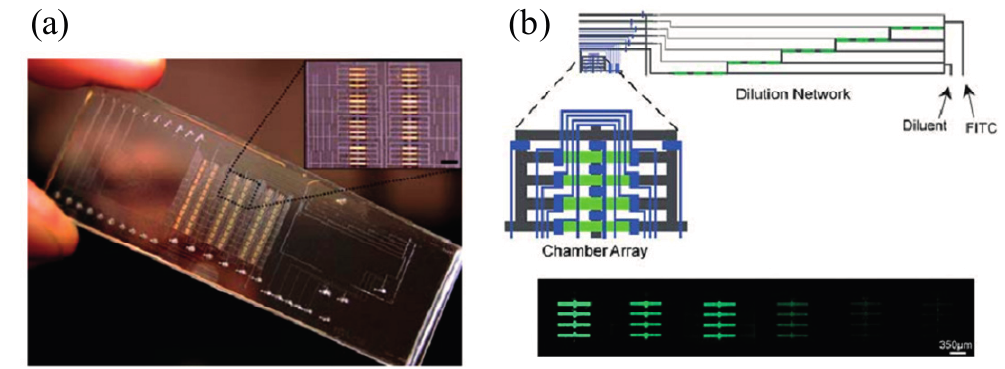
Figure 6. ( a ) Real image of the microfluidic device on a glass slide with gold patterns as a sensing surface. The inset shows a close-up region of the microarrays. ( b ) Top: Dilution channel network for a chaotic advection micromixer between 45 mM fluorescein and ddH O, Bottom: image of fluorescent intensity to show six different concentrations of the 2 fluorescein generated by the dilution network (Reproduced with permission from [65]).